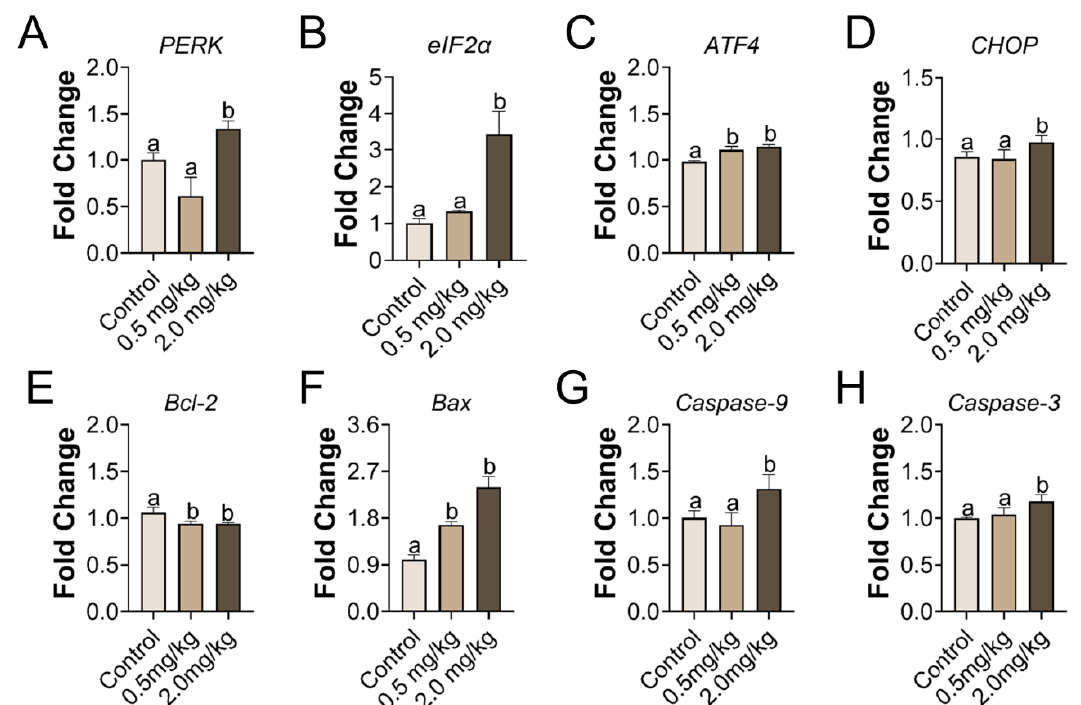
Figure 4. The mRNA expression of genes involved in ER stress and apoptosis in the ovary upon PS-MPs stimulation. ( A – D ) Relative expression levels of genes associated with ER stress, including PERK , eIF2 α , ATF4 , and CHOP . ( E – H ) Relative expression levels of genes associated with apoptosis, including Bcl-2 , Bax , Caspase-9 , and Caspase-3 . The information was presented as the mean ± SD. Different letters indicate significance. n = 3 per group.